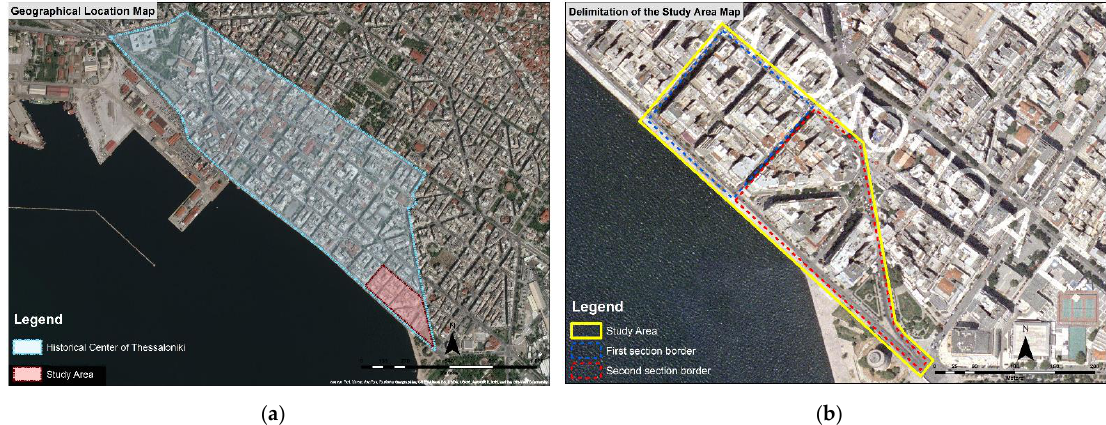
Figure 2. ( a ) The study area and the historic and commercial center of Thessaloniki; ( b ) Delimitation of the study area and the individual sections, ArcGIS software (basemap: orthophoto Cadastral SA).